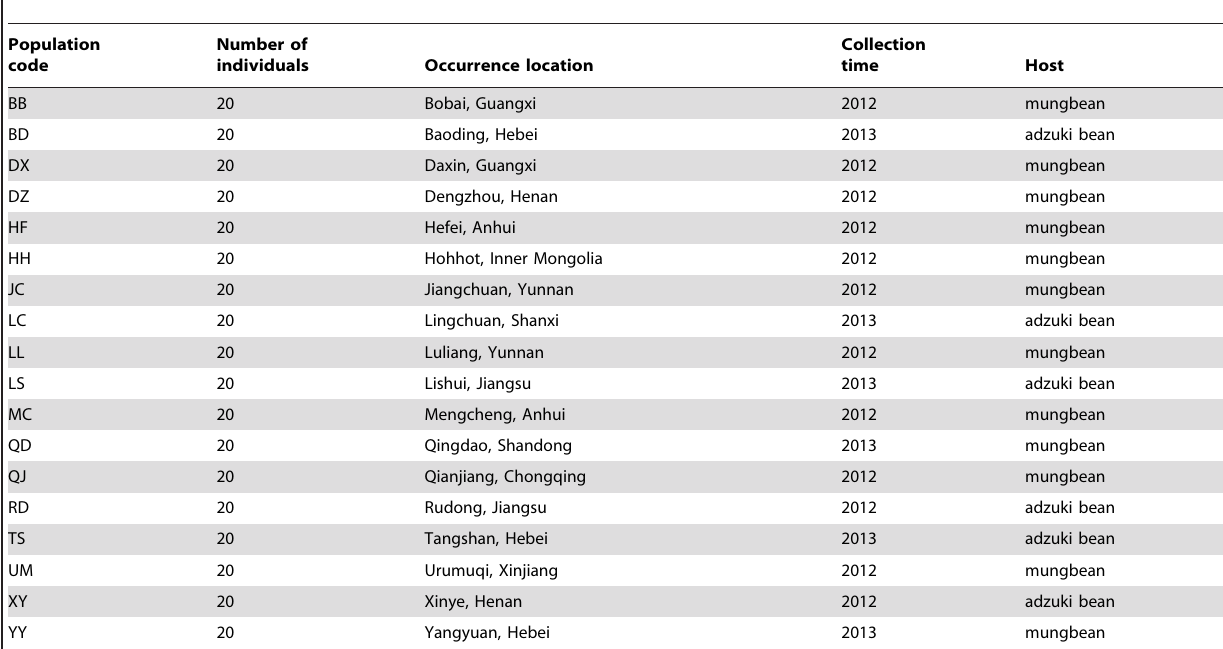
Table 2. The information of 18 Callosobruchus chinensis populations used in genetic diversity analysis.